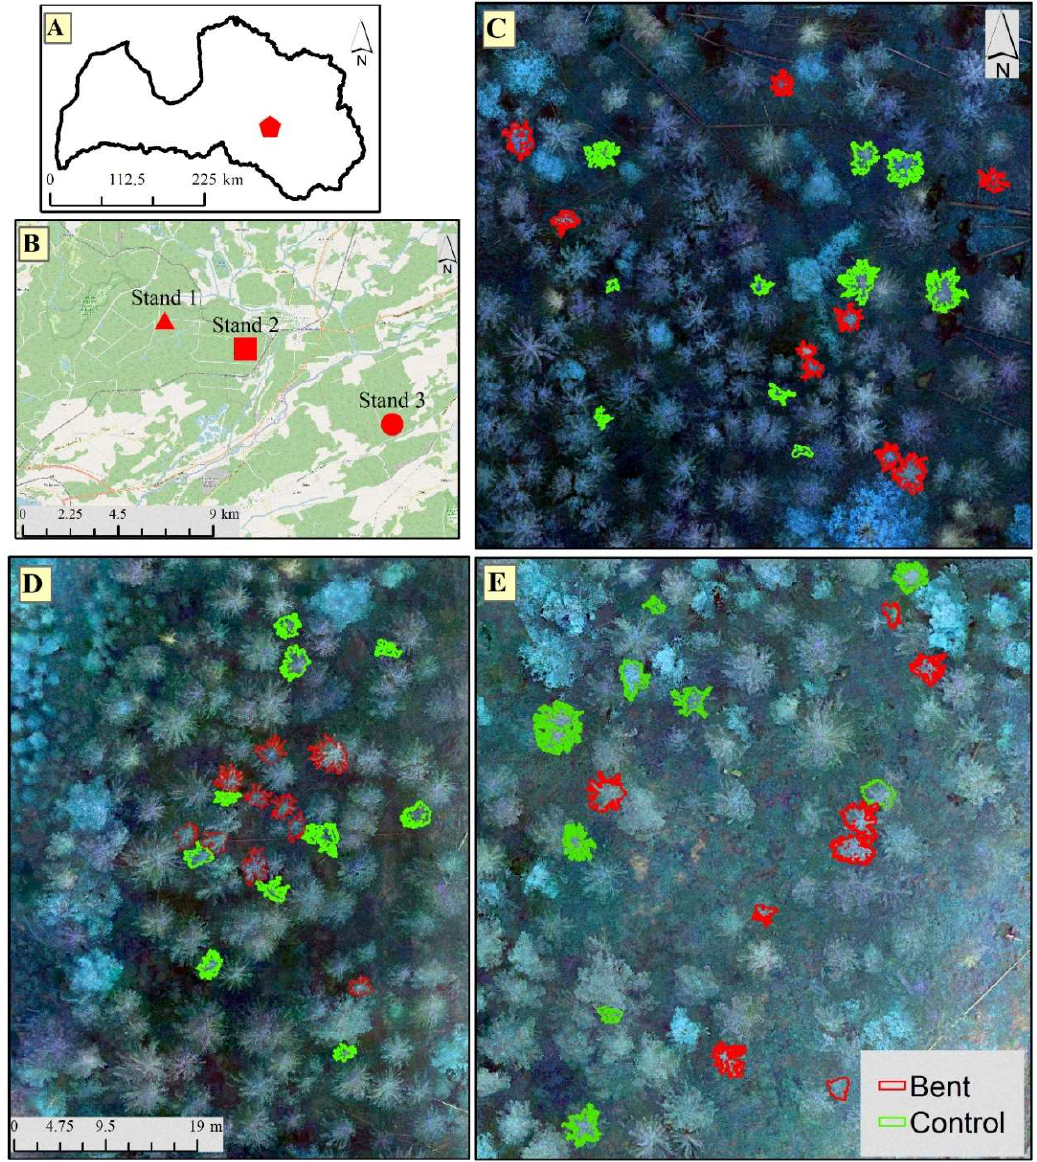
Figure 1 . Study area in the middle eastern part of Latvia: (A) Locations of stands in the Latvia; (B) Location of stands on a local scale (data obtained from OpenStreetMap (www.openstreetmap.org)); (C, D and E) Placement and delineation of Bent and Control trees in Stand 1, Stand 2 and Stand 3, respectively. The background ortomosaics were acquired in May 7, 2021 and are showing the combination of Red, Green and RedEdge